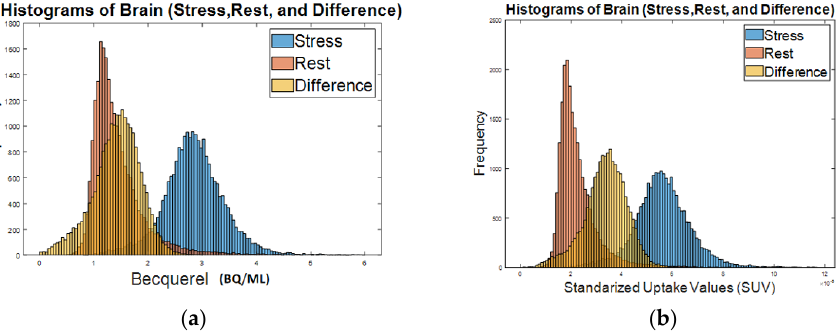
Figure 2. Histograms of FDG RBC tracer activity in a representative rat brain (pharmacological vasodilatory “stress”, rest, and the difference between stress and rest): ( a ) intensity activity (Bq/mL) in the brain; ( b ) standardized uptake value (SUV) in the brain.